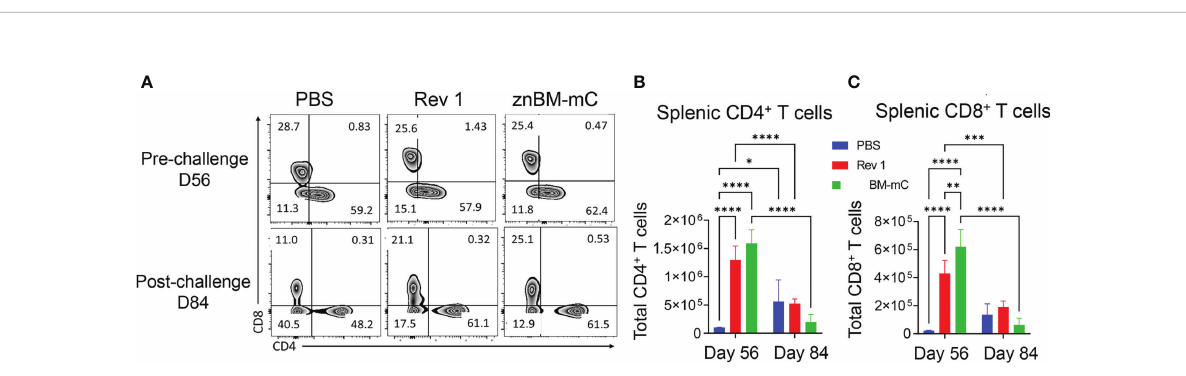
FIGURE 5 Mucosal vaccination with znBM-mC induces T-cell expansion in the spleens. Groups of mice were vaccinated with sPBS, Rev 1, or znBM-mC, and then subjected to pulmonary challenge with 5 × 10 4 CFUs wt B. melitensis 16M as described in Figure 2. (A) Flow cytometric analysis of isolated splenic lymphocytes previously gated on singlets, CD45 + , TCR b + cells, and then gated as CD4 + and CD8 + T-cell subsets. Total numbers of splenic (B) CD4 + T cells and (C) CD8 + T cells on days 56 (pre-challenge) and 84 (post-challenge) are shown. Data are representative of two independent experiments with n = 5 – 7 mice/group. Differences within T-cell subsets compared to PBS-dosed mice of that subset as well as differences between treatment groups at both timepoints analyzed are shown: *p <0.05; **p <0.005, ***p <0.0005, and ****p <0.0001. Two- way analysis of variance (ANOVA) followed by Tukey ’ s multiple comparisons test was used for statistical